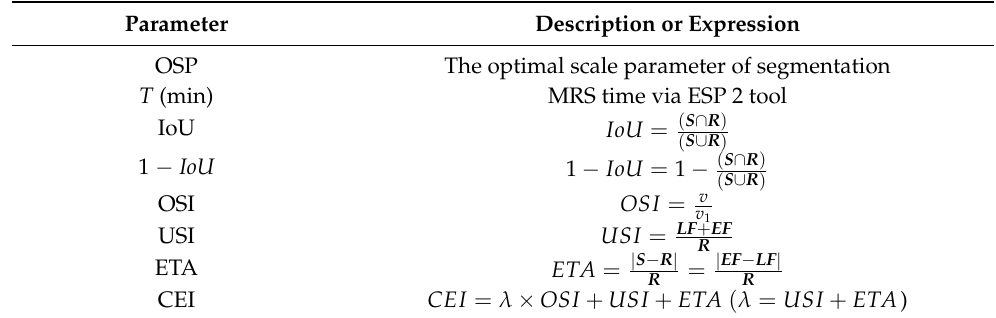
Figure 5. Extracting EPGSs from FI based on point samples: ( a ) segments intersecting with point samples; ( b ) EPGSs. Table 4. The description or expression of evaluation